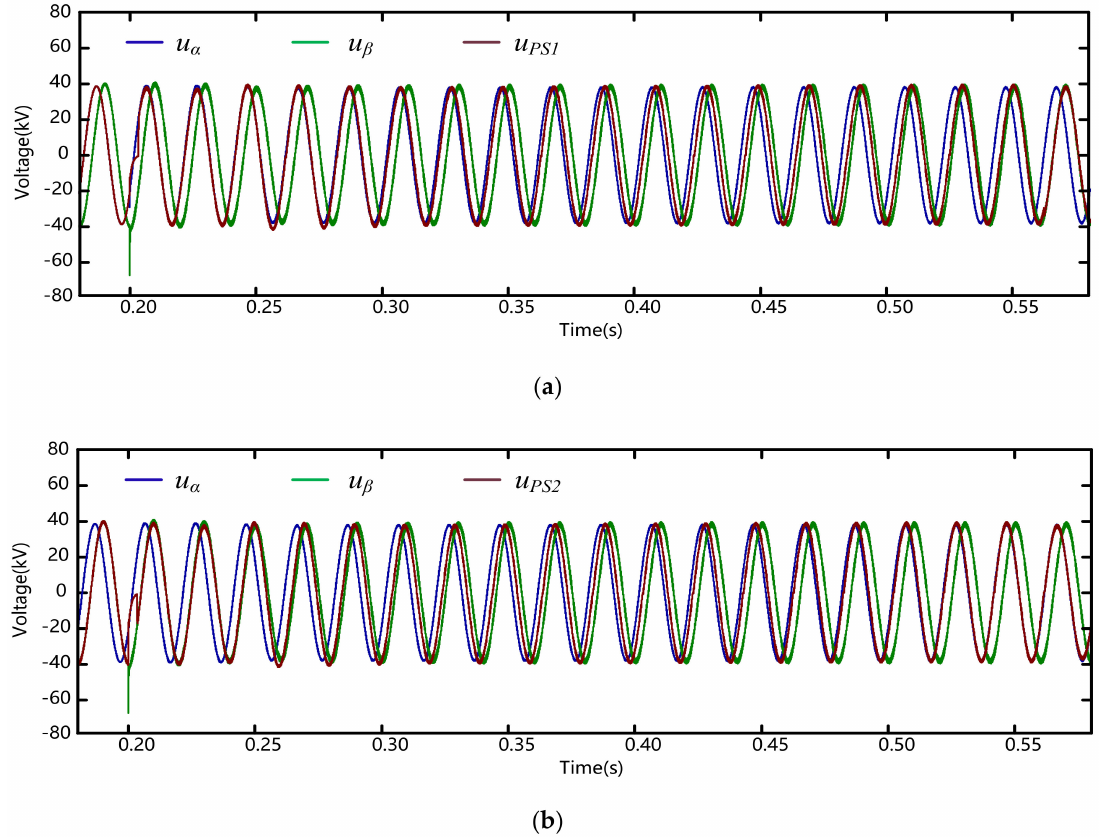
Figure 5. Voltage waveforms of traction feeders and PS in UPSP mode: ( a ) upward PS; ( b ) downward